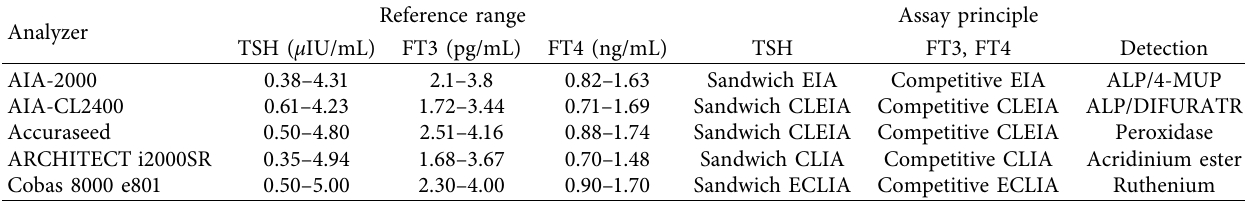
Table 1: The characteristics of the immunoassay systems tested in the present